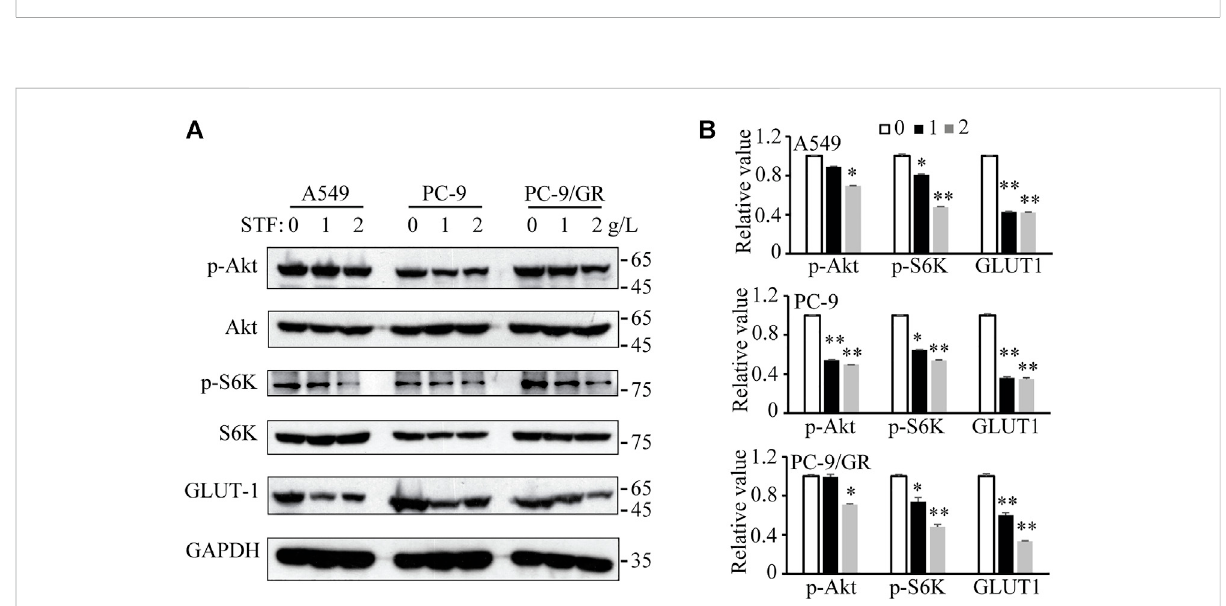
FIGURE 4 STF downregulated the PI3K/Akt signaling pathway and glucose transporter 1 (GLUT1) levels in NSCLC cells (A) Similar to Figure 1B, the cells were treated with STF and then subjected to immunoblotting to determine the levels of p-Akt, p-S6K and GLUT1. (B) The relative levels of these proteins are presented. * p < 0.05, ** p <